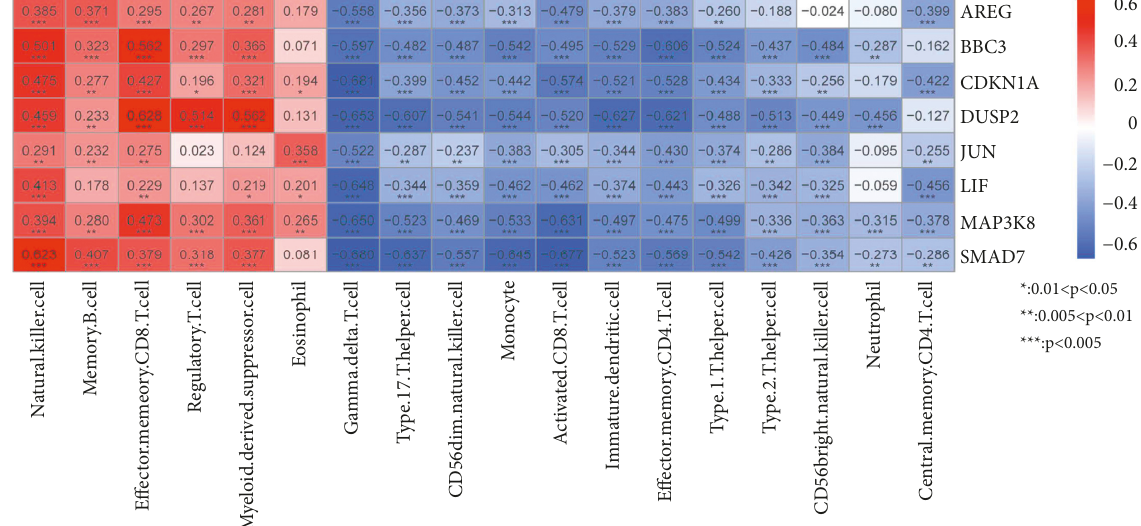
Figure 12: We use R3 6.1 the cor function in the language calculates the PCC between the expression level of 8 characteristic immune DEGs in the combined samples and the 18 immune cell types with significant differences in the distribution between the groups previously screened, and then displays the correlation to observe the correlation between the expression level of characteristic DEGs and related immune cells and the results are shown in Figure